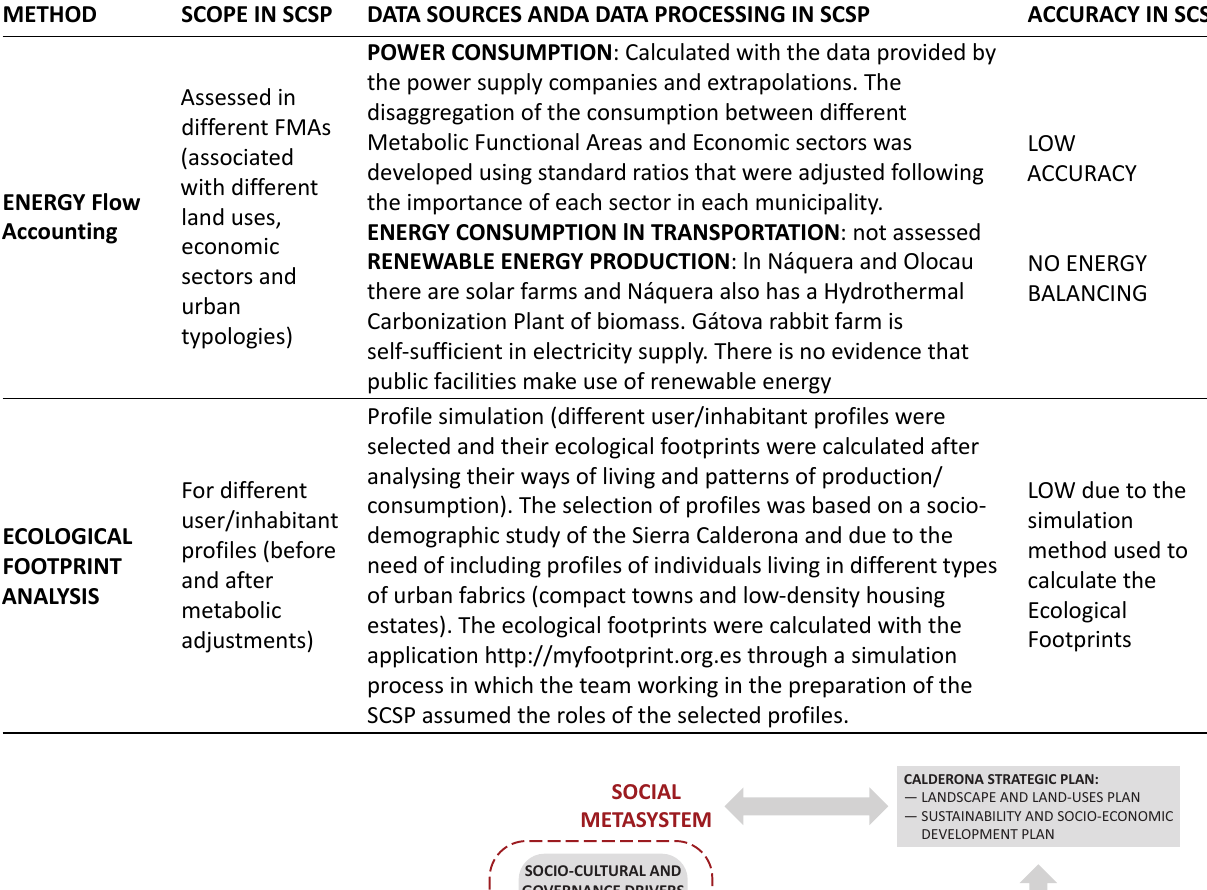
Table 1. (Cont.) Metabolic methods, application scopes, data sources and data processing used in the SCSP.